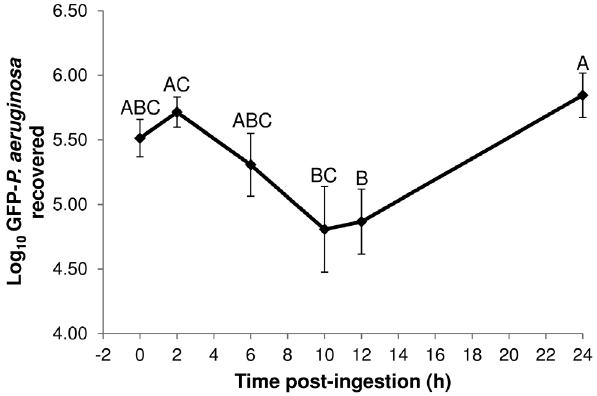
Figure 2. GFP- P.aeruginosa persisted and proliferated within the house fly. House flies (n=20 in each of three replicates) were fed an average of 3.60 6 10 5 CFU (SD=1.75 6 10 5 ) bacteria. At 2, 6, 10, 12, and 24 h post-ingestion, GFP- P. aeruginosa were enumerated from whole flies (n=4 per replicate) by culture on selective media. Details on culture methods and statistical analysis are in the text. Different letters represent significant differences between mean CFUs recovered from flies (P # 0.04), and error bars are standard error.